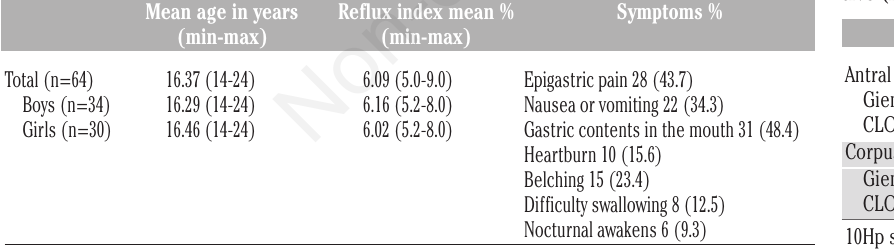
Table 3. Helicobacter pylori positive/nega- tive (n=64).